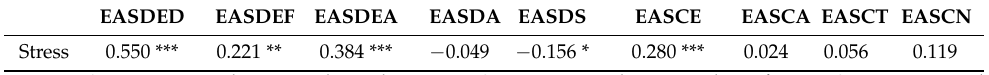
Table 4. Correlations between temperamental traits and parental